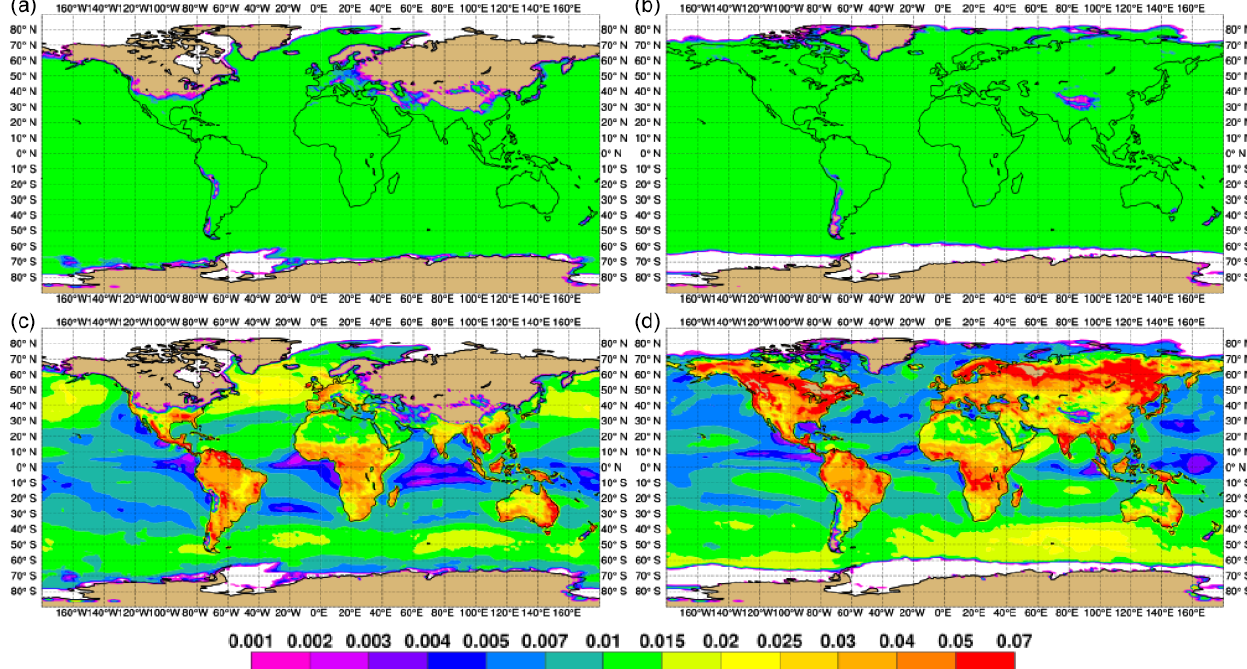
Figure 8. January (a, c) and July (b, d) 2014 average of the dry deposition velocity of super-coarse sea salt computed with R05 (a, b) and ZH01 (c, d) (ms − 1